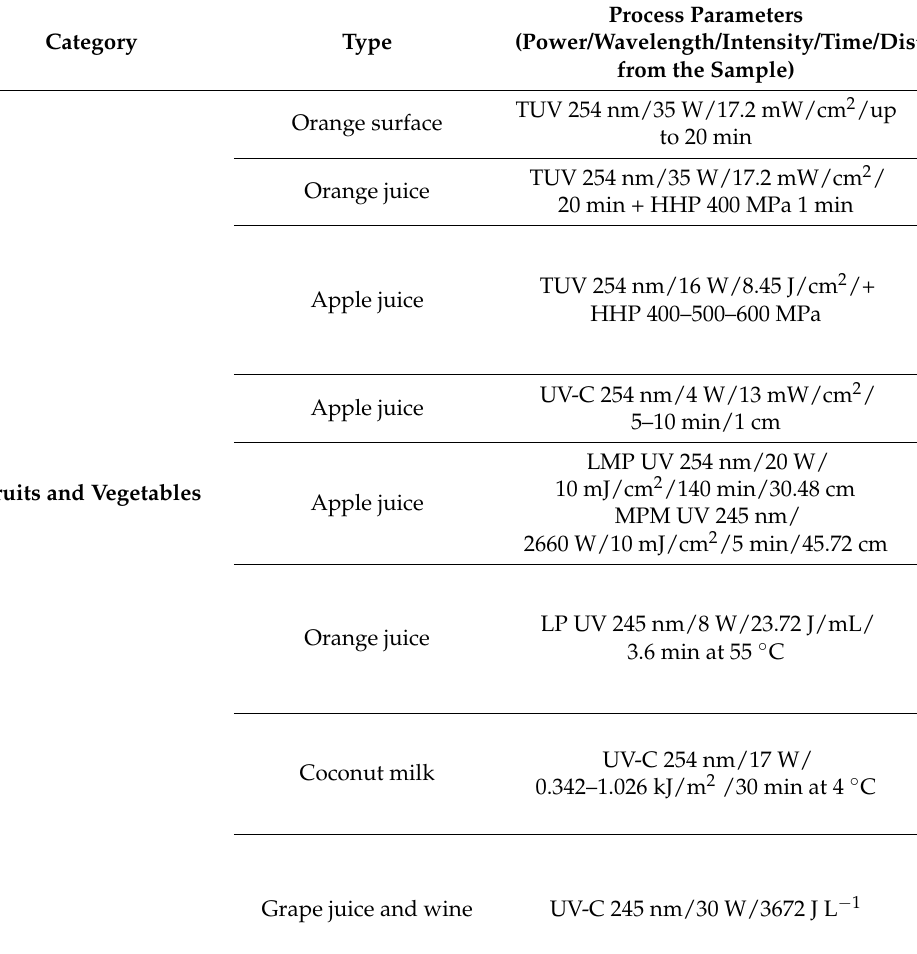
Table 3. Different food types, together with UV light process parameters and